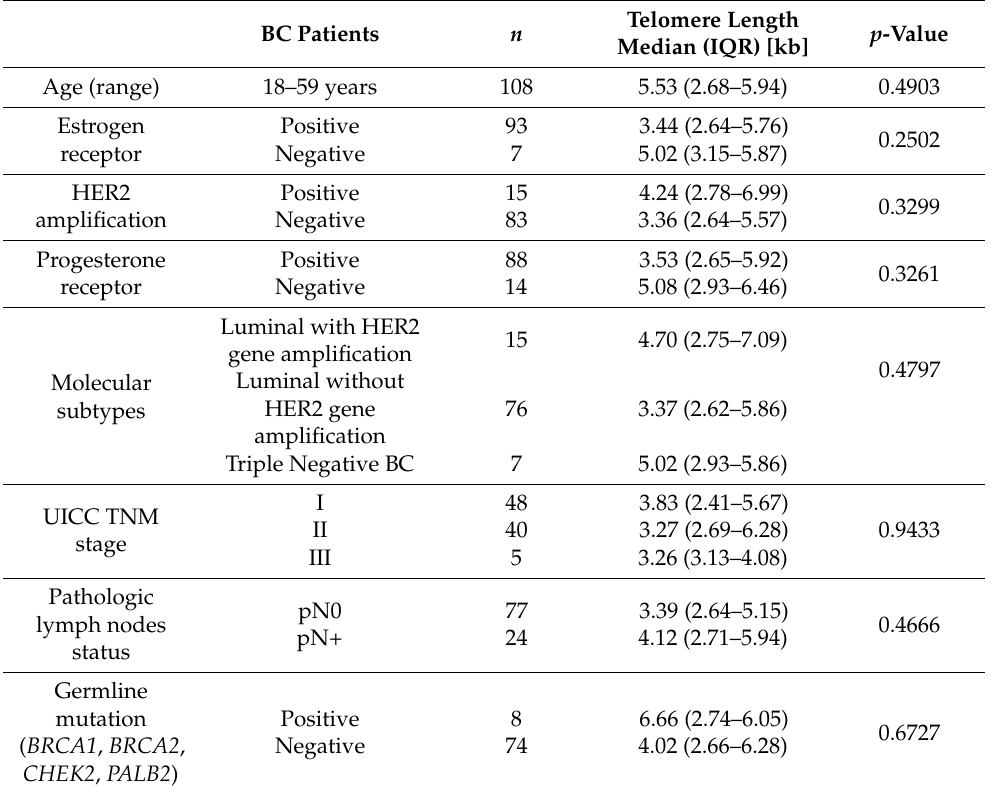
Table 3. Relationships between telomere length and various clinical parameters in patients with BC. BC